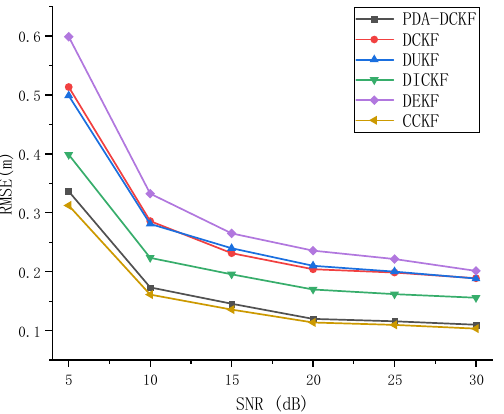
Figure 5. RMSE versus SNR for different tracking algorithms with T 60 = 200